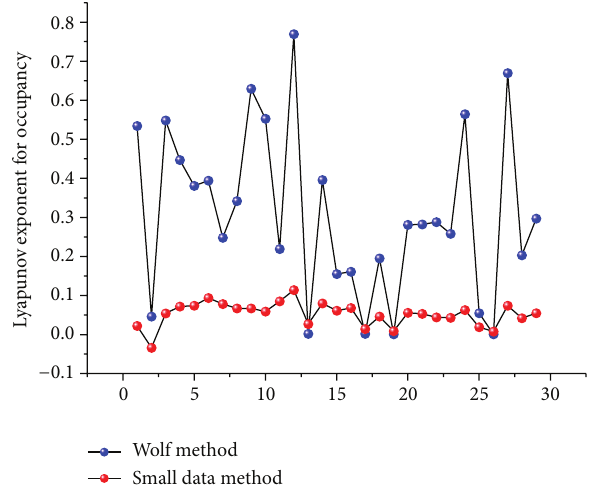
Figure 9: The largest Lyapunov exponents of occupancy time series from 29 detectors. Results from Wolf method are positive, and only value at 2nd detectors is negative by small data method. Table 6: Uncertainty conditions from chaotic analysis results. Detector